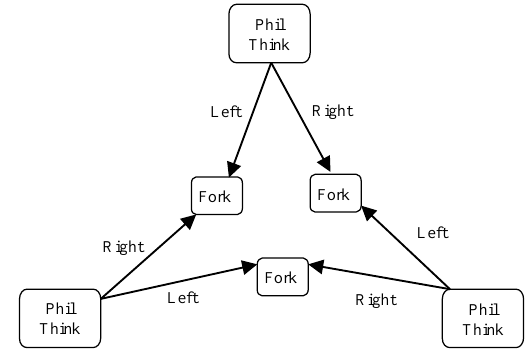
Figure 3. Host graph of the dining philosopher problem with 3 philosophers and forks.